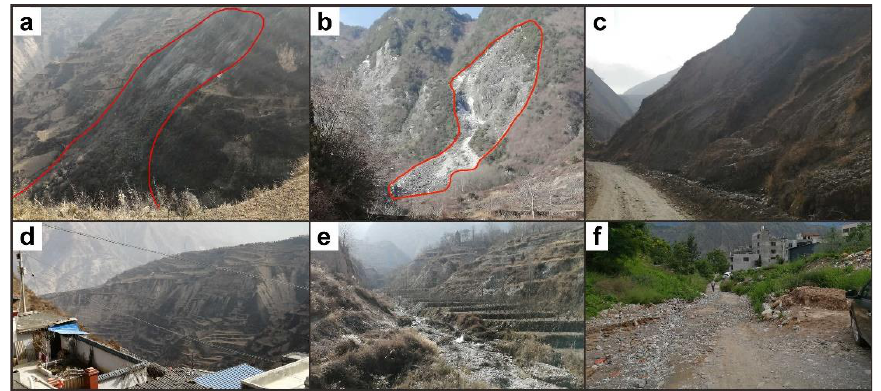
Figure 5. Main source of the Boshuigou debris flow: ( a ) landslide at the source; ( b ) rock collapse at the source; ( c ) collapse at the flow path; ( d ) slope erosion at the flow path; ( e ) deposits at the flow path; ( f ) deposits at the deposition area.